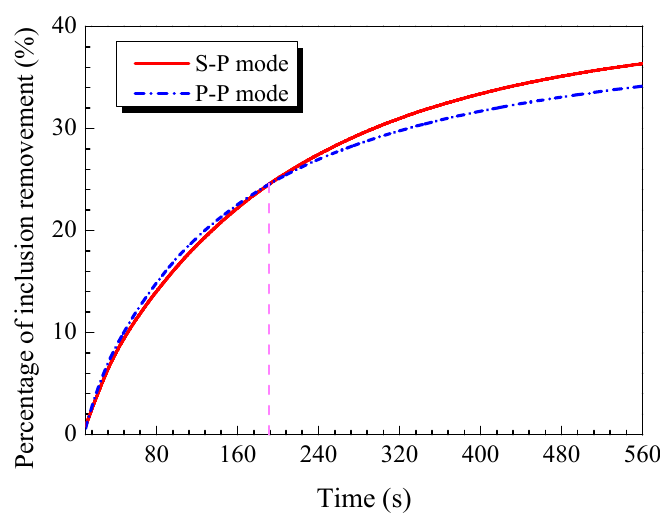
Figure 11. Percentage of inclusion removal at di ff erent modes.